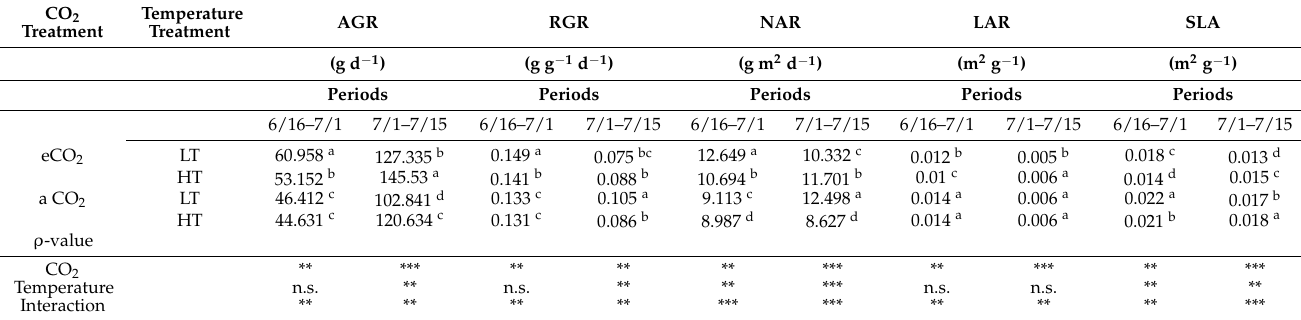
Note: Different lower-case letters in the same column indicate a significant difference among treatments (LSD multiple range test, p < 0.05, n.s.: non-significant Differenc, **: significant at p < 0.01, ***: significant at p <